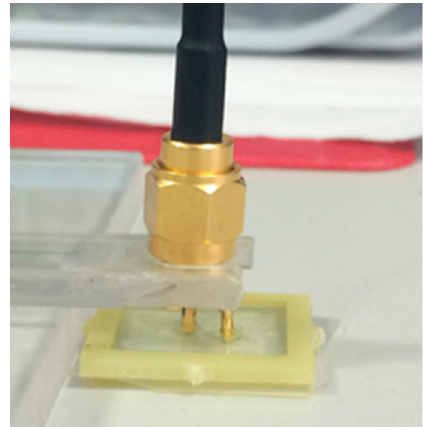
Figure 1. Gold plated sensor used in low-frequency capacitance measurements.